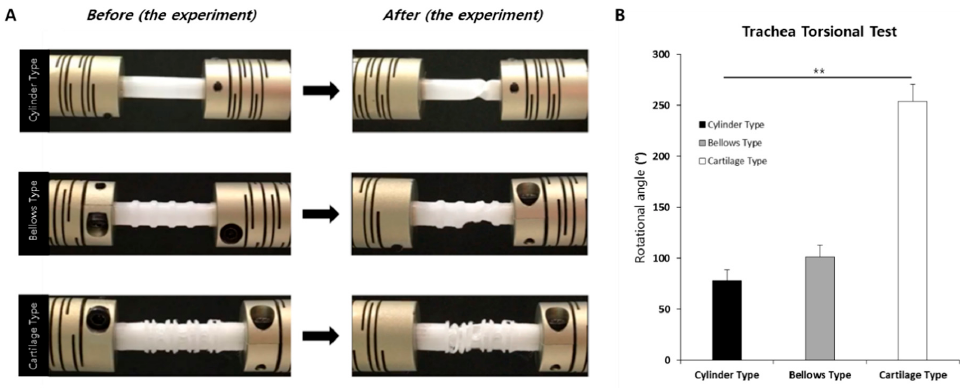
Figure 9. Torsional test results of the tracheas. ( A ) Experiment, ( B ) Rotation angle graph. (** p < 0.001)